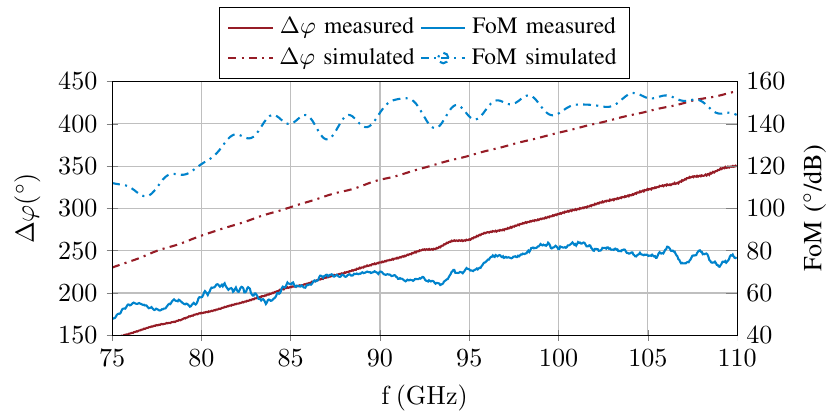
Figure 18. Measured and simulated differential phase shift and FoM applying a differential voltage of 300V of the DIL phase shifter.